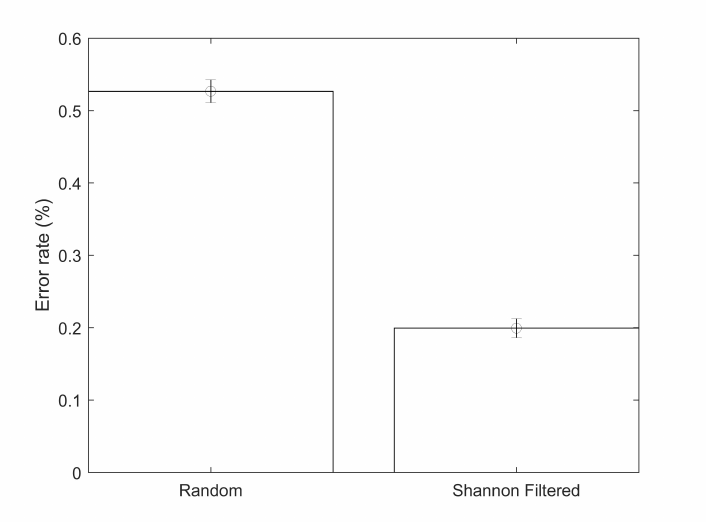
Figure 7. Error rate comparison between the Shannon Entropy filtered approach and random selection of the same